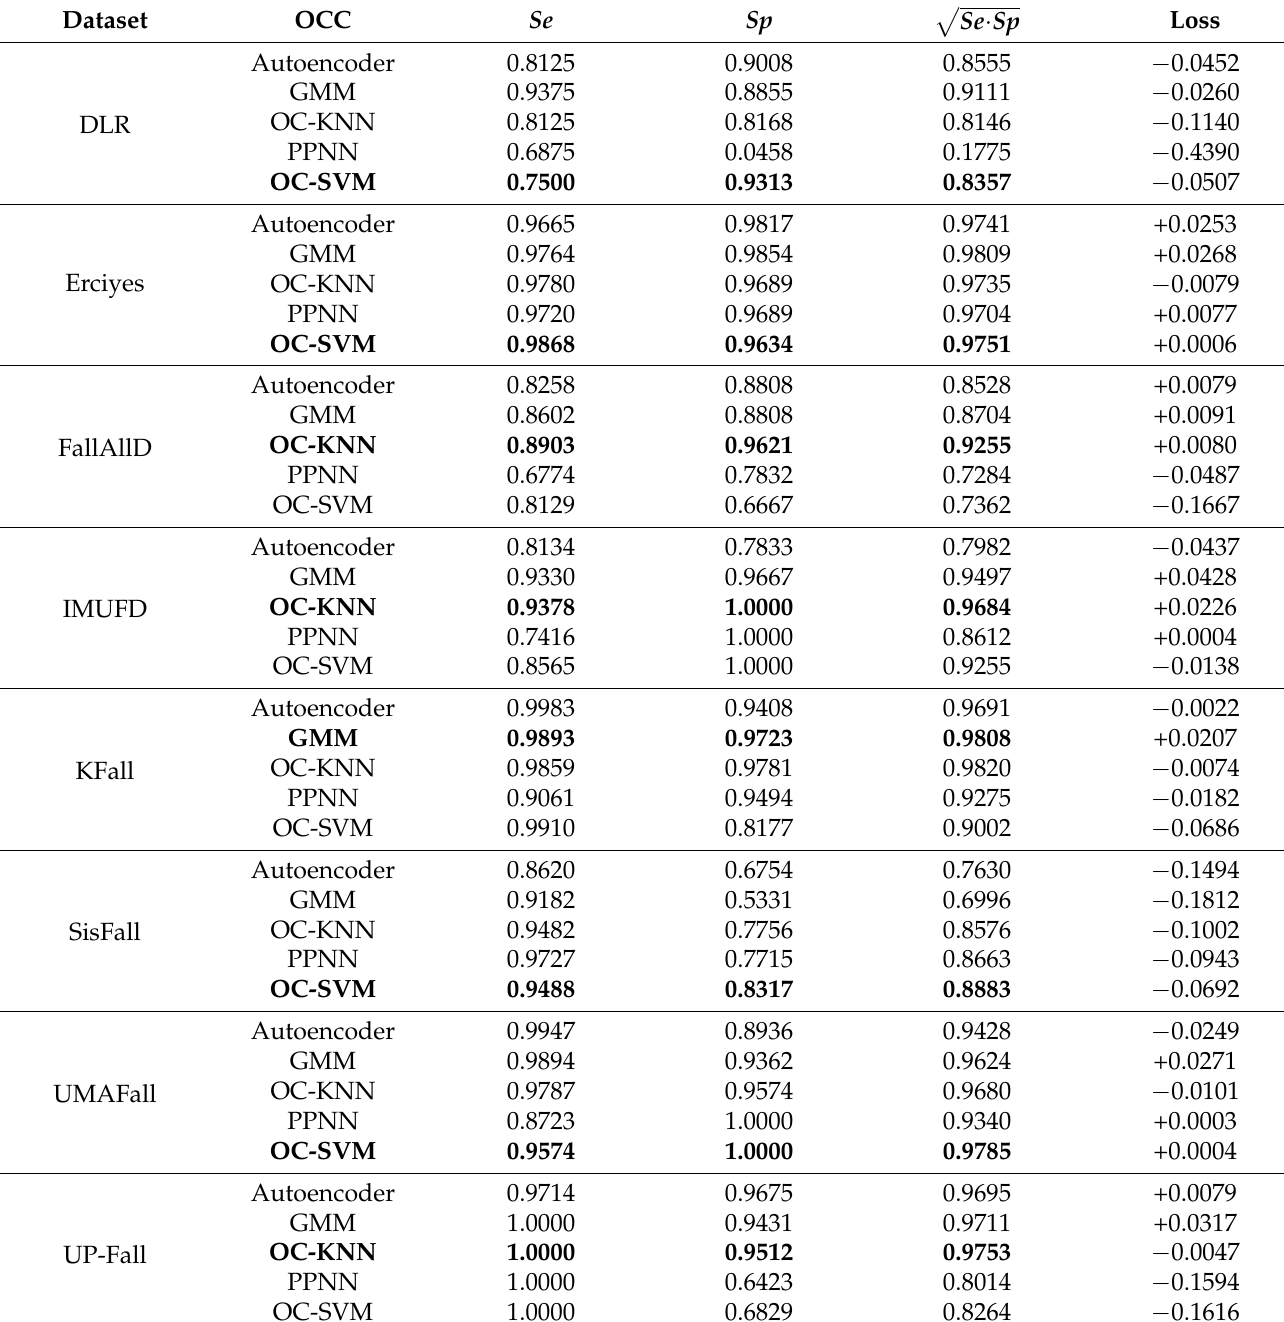
Table 12. Results of the classifiers when they are tested with falls and standard movements and trained with the rest of ADL